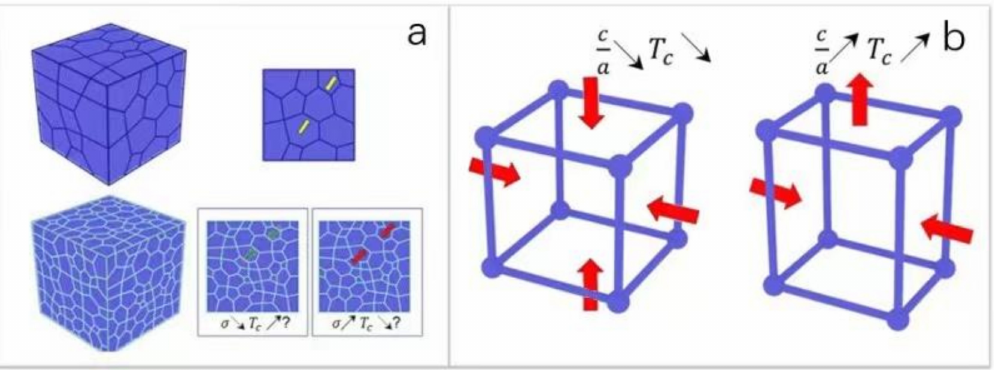
Figure 4. Schematic of the mechanism affecting the Curie point and its contradictions: ( a ) from grain size aspect; ( b ) from lattice constant ratio